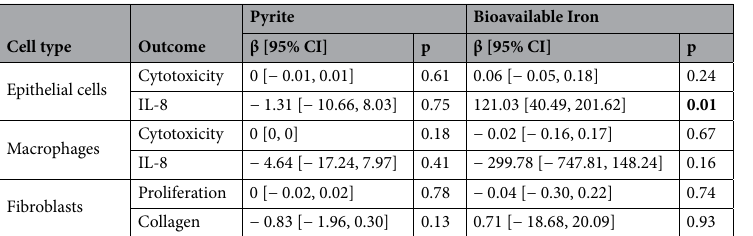
Table 2. Outcomes of linear regression analyses, adjusted for particle size, for the association between cell responses and the properties of the coal particles the cells were exposed to (pyrite content and bioavailable iron). Bold indicates p <